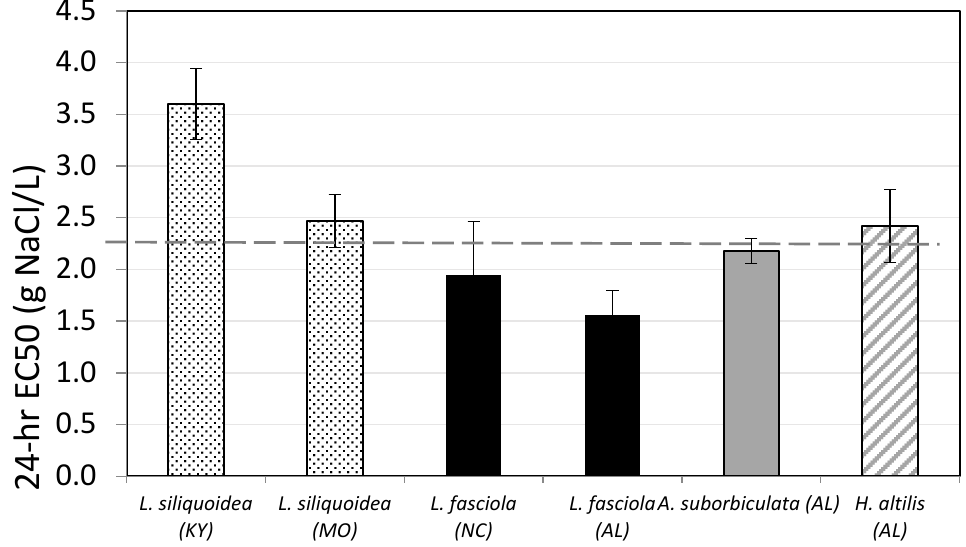
Figure 2. Twenty-four-hour NaCl EC50s for glochidia from Lampsilis siliquoidea , L. fasciola , Anodonta suborbiculata , and Hamiota altilis (state of origin in parenthesis). All tests were conducted in moderately hard reconstituted water (hardness 80–90 mg/L) at 20 ◦ C. The dashed line indicates the geometric mean of the EC50s for the six tests. Error bars represent 95% confidence limits.